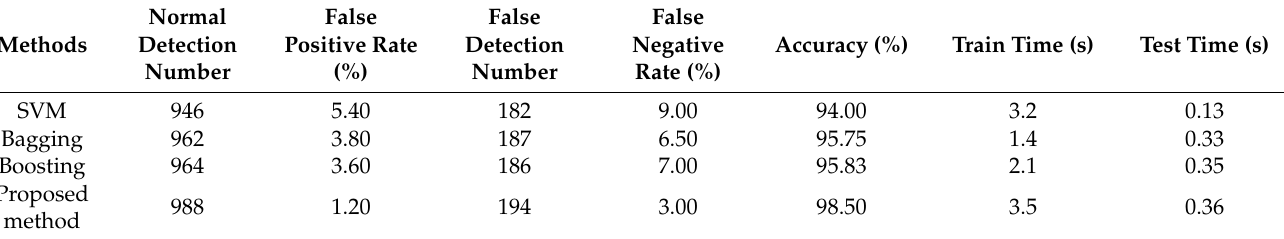
Table 4. Experimental results of fatigue